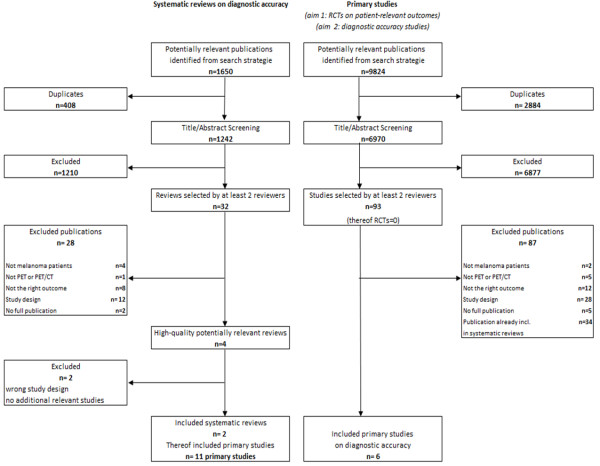
Flow chart of study.